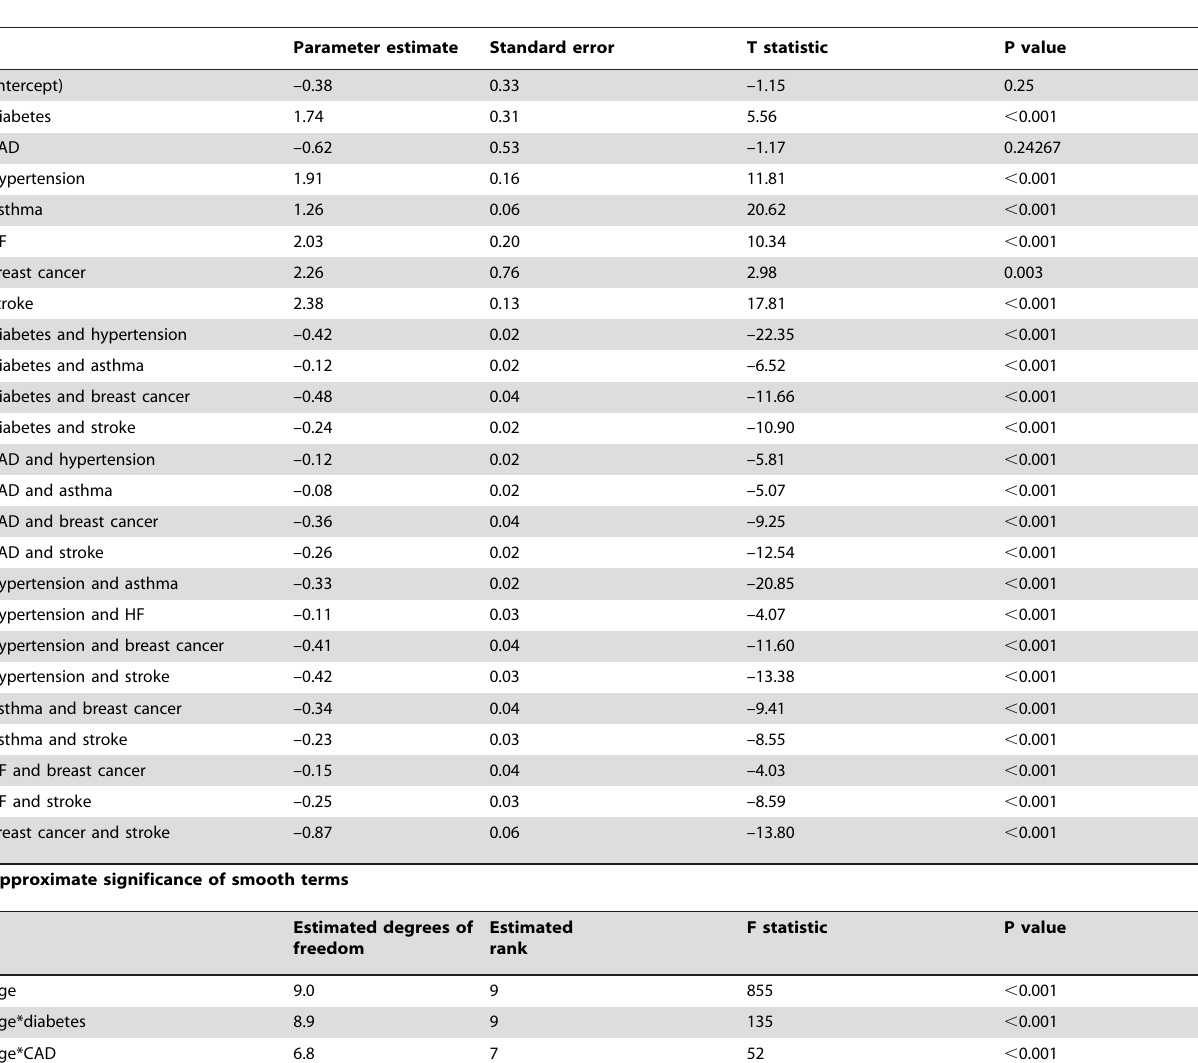
Table 2. The estimates, standard errors and test statistics of the variables in the generalized additive